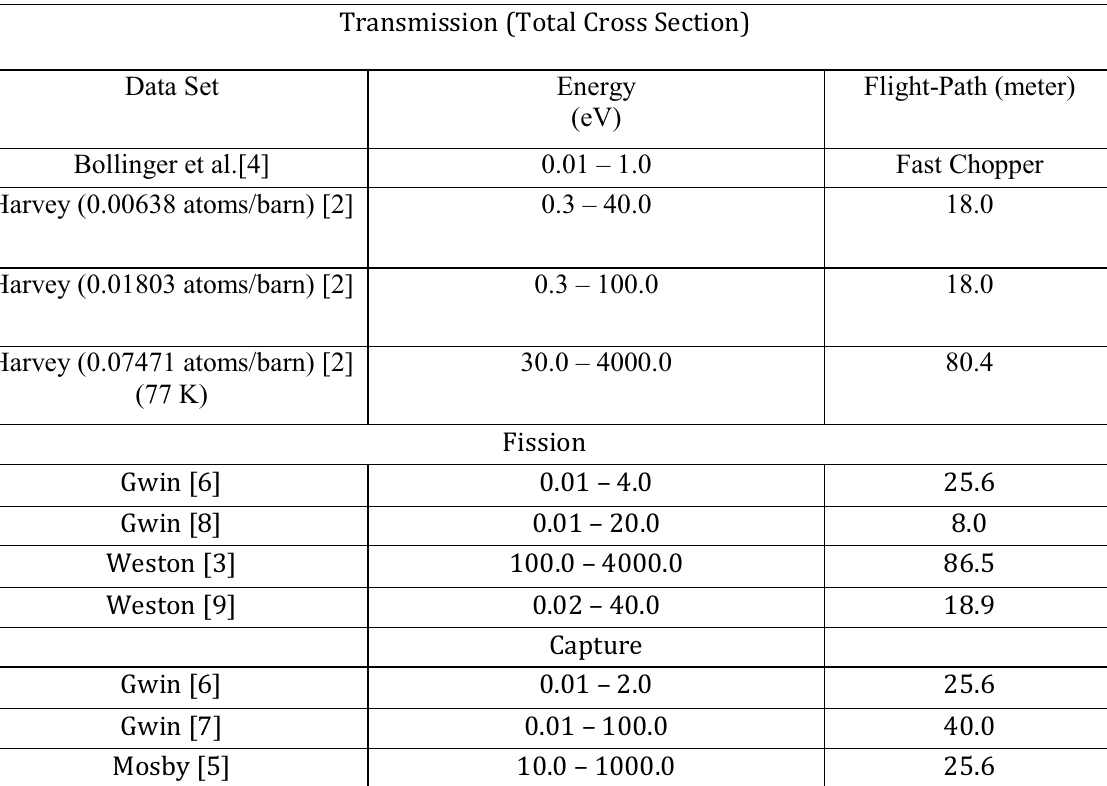
Table II: Experimental